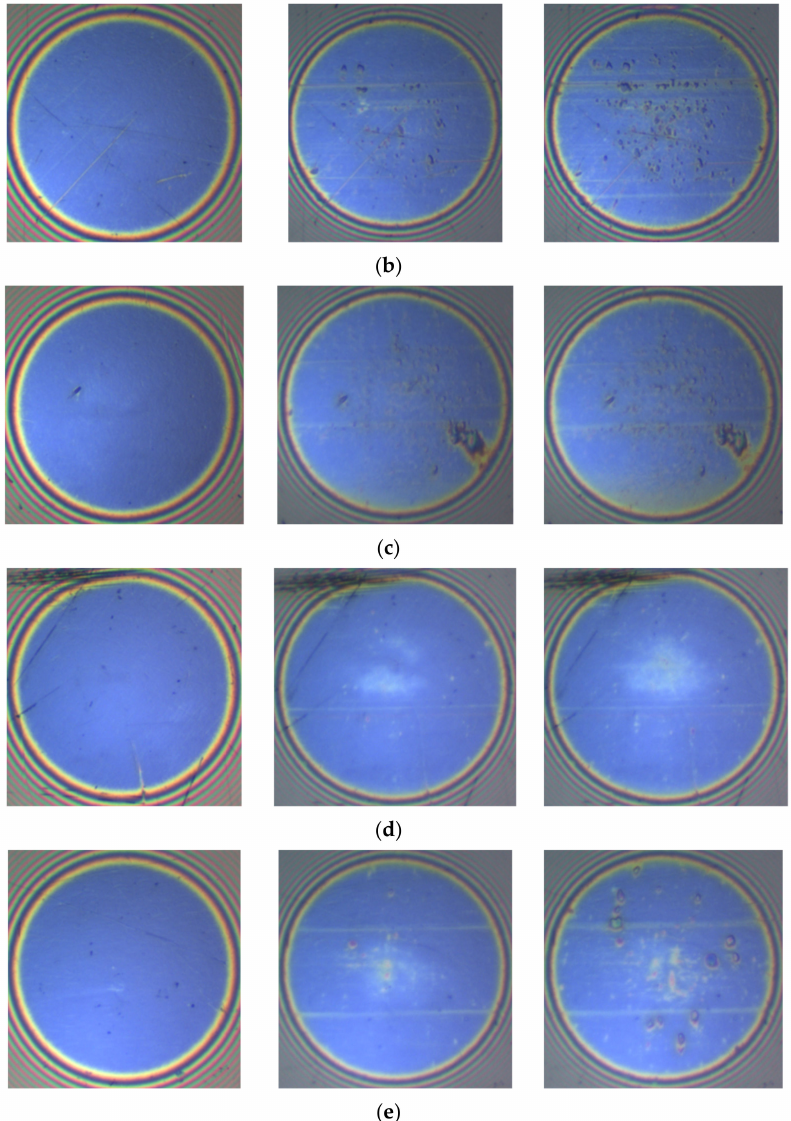
Figure 7. Series of interference images for different concentrations of nanoparticles after increasing rubbing time: ( a ) IL, ( b ) IL + 0.2 wt% CuO, ( c ) IL + 0.5 wt% CuO, ( d ) IL + 0.2 wt% ZnO, and ( e ) IL + 0.5 wt%